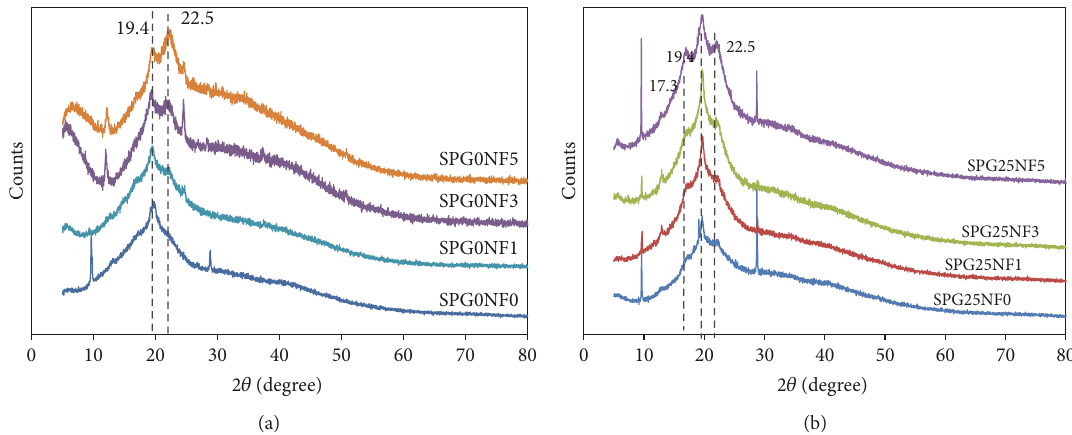
Figure 3: XRD Profiles of TPS/PVA cellulose nanocomposite films (a) without glycerol; (b) with glycerol.